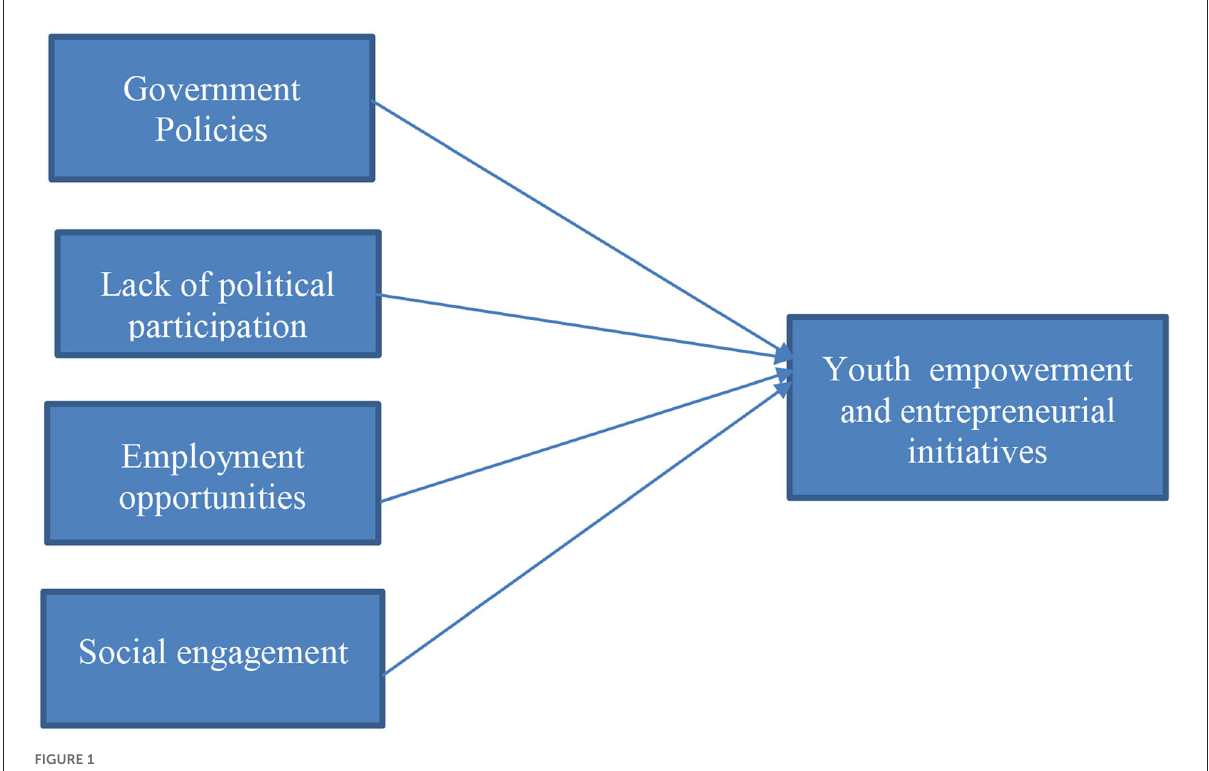
FIGURE1 Conceptual framework.